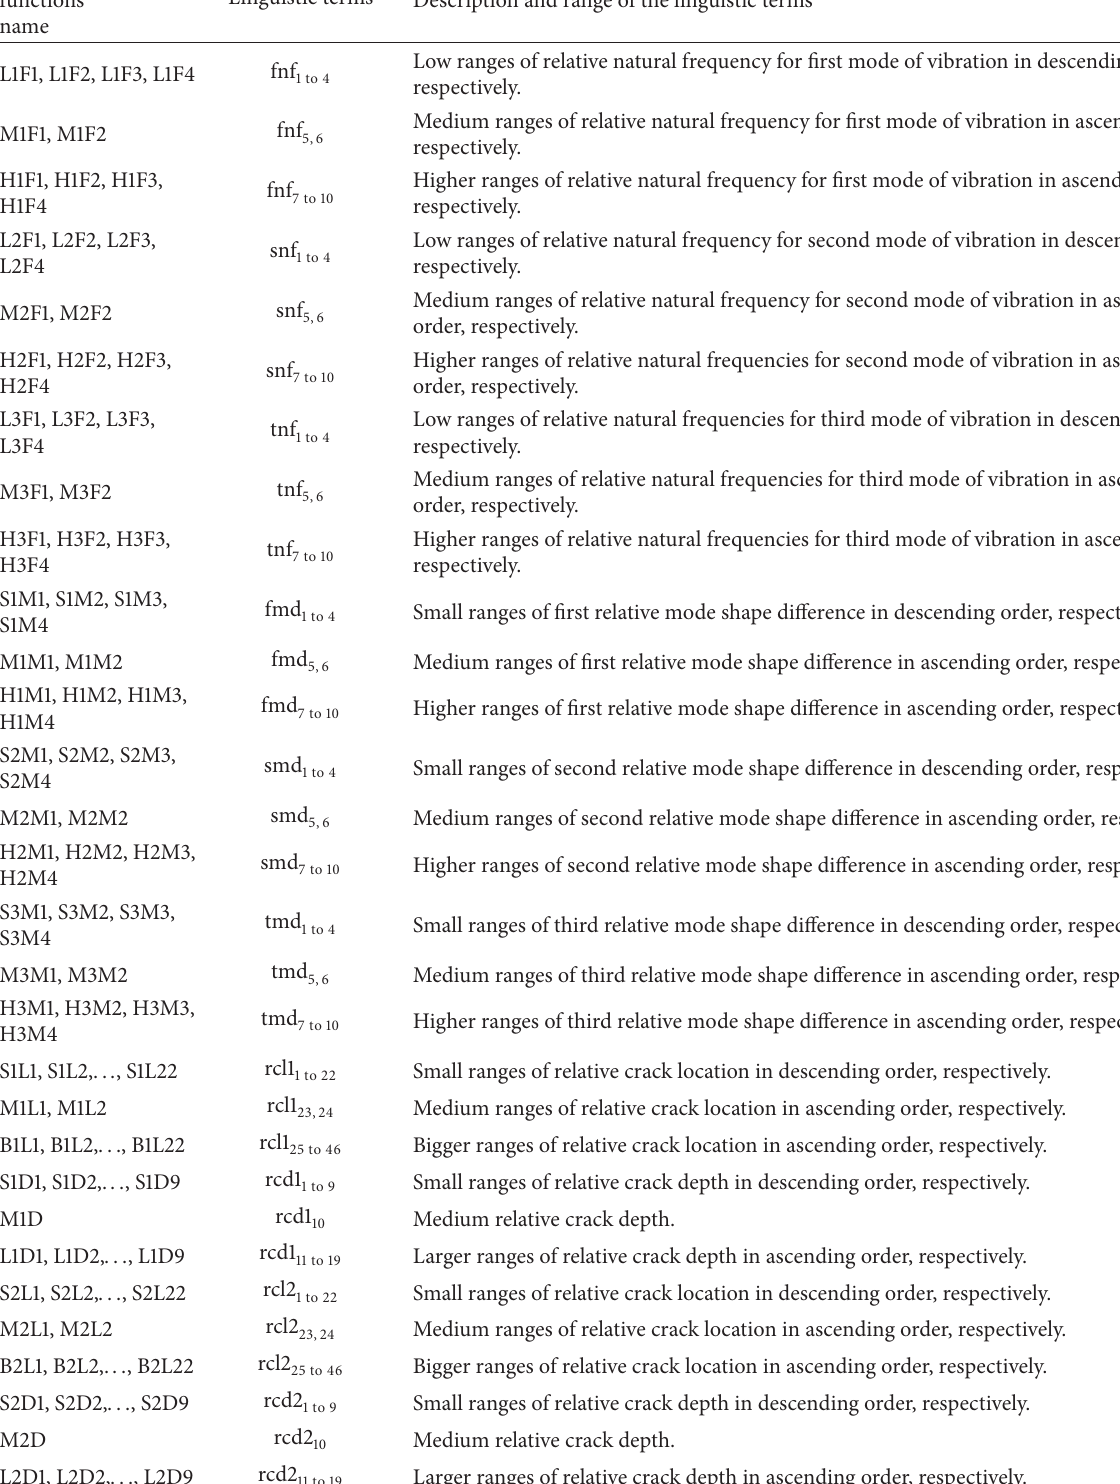
Table 1: Description of fuzzy linguistic